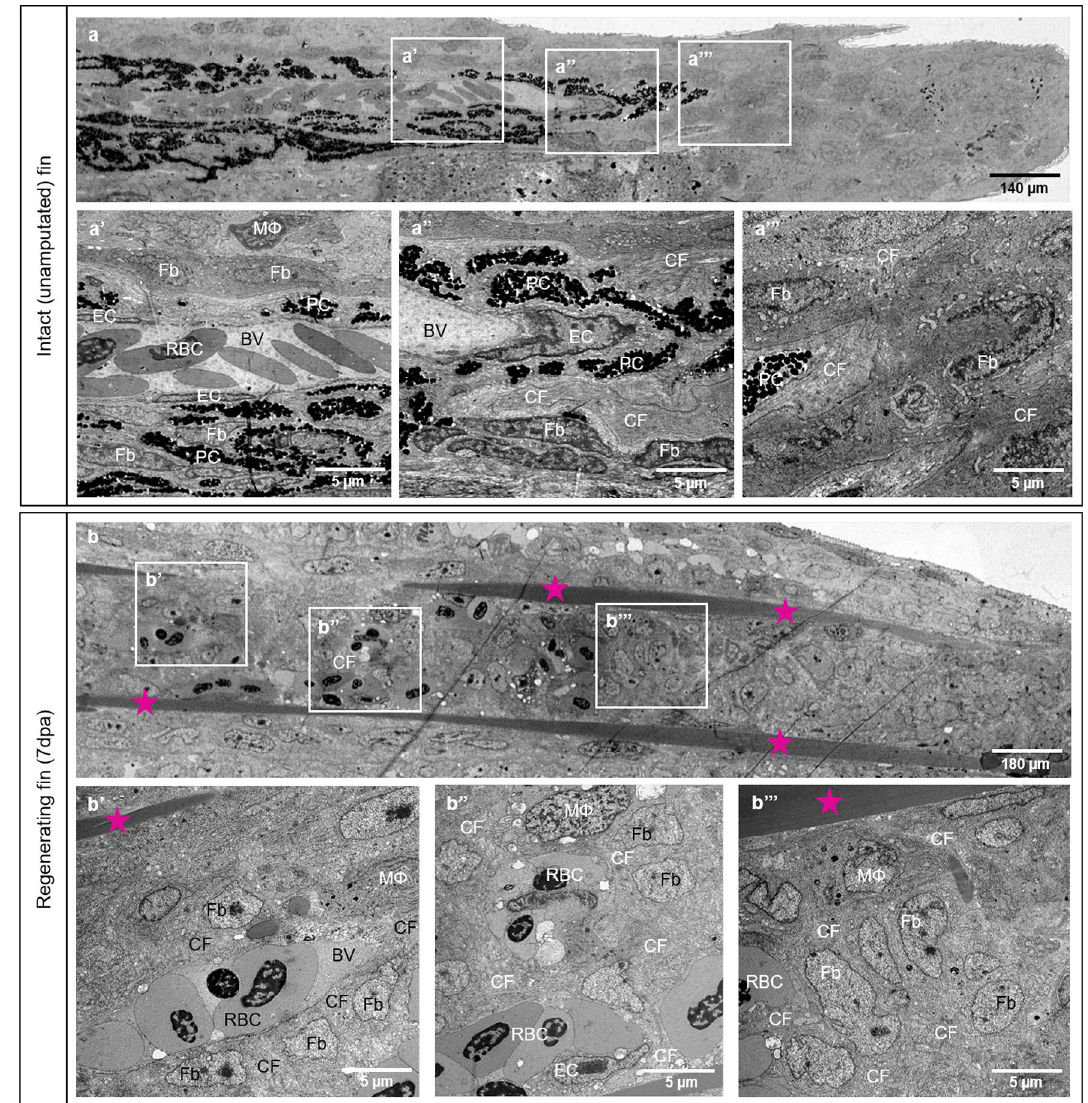
Figure 2. Differences in tissue compartments between the intact (unamputated) caudal fin and fin during early regeneration. Structural differences between intact caudal fin ( a ) and early regeneration at 7dpa ( b ) are demonstrated by transmission electron microscopy. a-a’’ display perfused and mature blood vessel with quiescent and well-differentiated endothelial cells (ECs), pigment cells (PC) and ECM containing robust collagen fibers (CF), fibroblasts (Fb) and very seldom solitary macrophage (MΦ). In the regenerating fin (7dpa), robust collagen fibers (CF) are arranged into two densely packed stripes tracing the future ray bones ( b , asterisk). Between the latter, new formed, immature blood vessel (BV) containing red blood cells (RBC) are enclosed by scaffold of CF tracing the direction of blood vessel expansion ( b’ ). The CFs are surrounded tightly by Fb and MΦ ( b’ ). At the vascular front, next to new formed capillaries containing ECs, clusters or single RBC are detectible ( b’’ ). In the blastema, multiple Fb proliferate displaying classical mitotic figures; ECM contains CF and MΦ ( b’’’ ). PC are absent during the regenerative phase. Left side - zebrafish trunk, right side - zebrafish tail, images acquired by electron